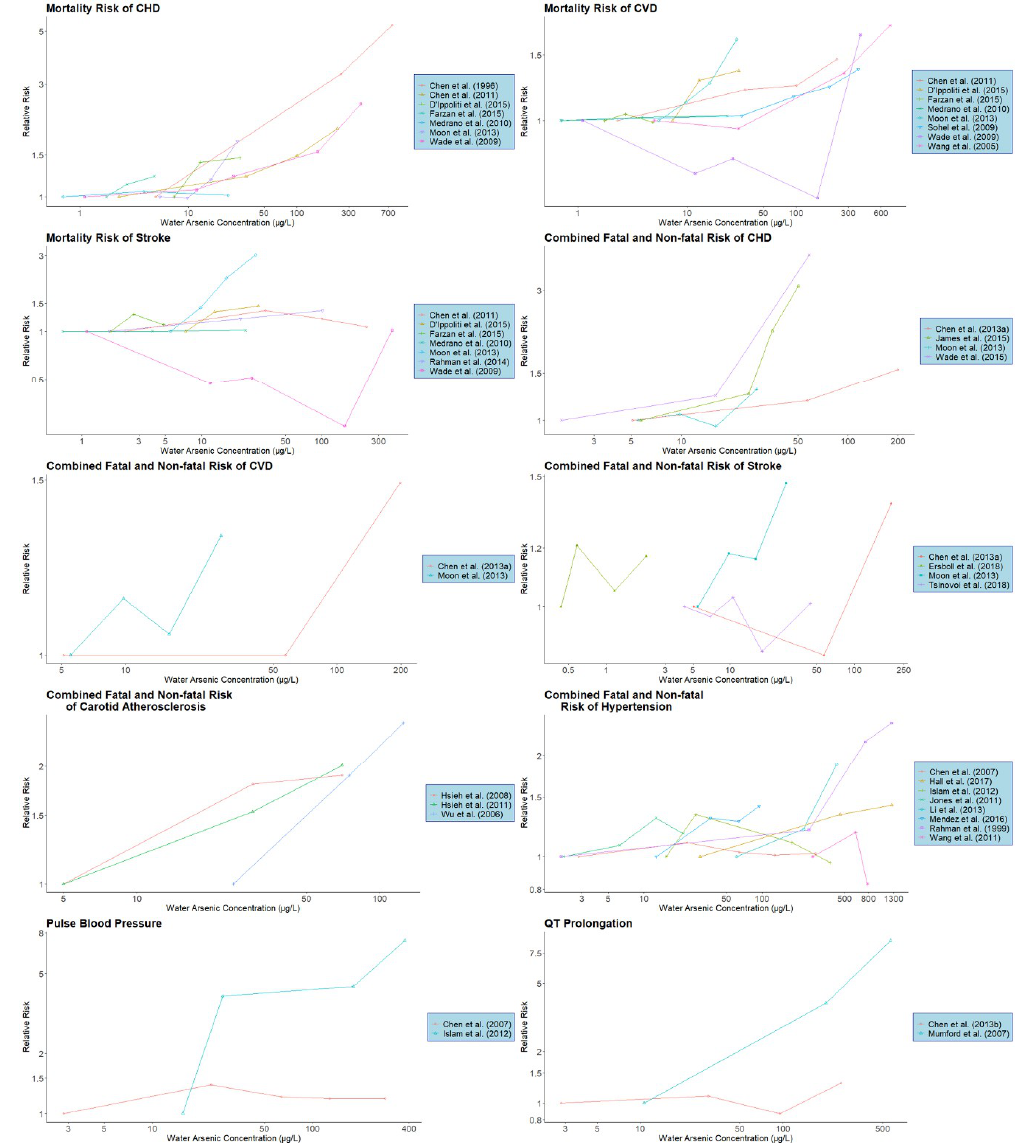
Figure 1. Individual study dose-response characteristics for various CVD subtypes or biomarkers. Arsenic concentrations refer to the observed or estimated median arsenic concentrations for the given concentration category. Lines connect the dose-response data for each study and are for illustrative purposes only (CVD: cardiovascular disease; CHD: coronary heart disease).